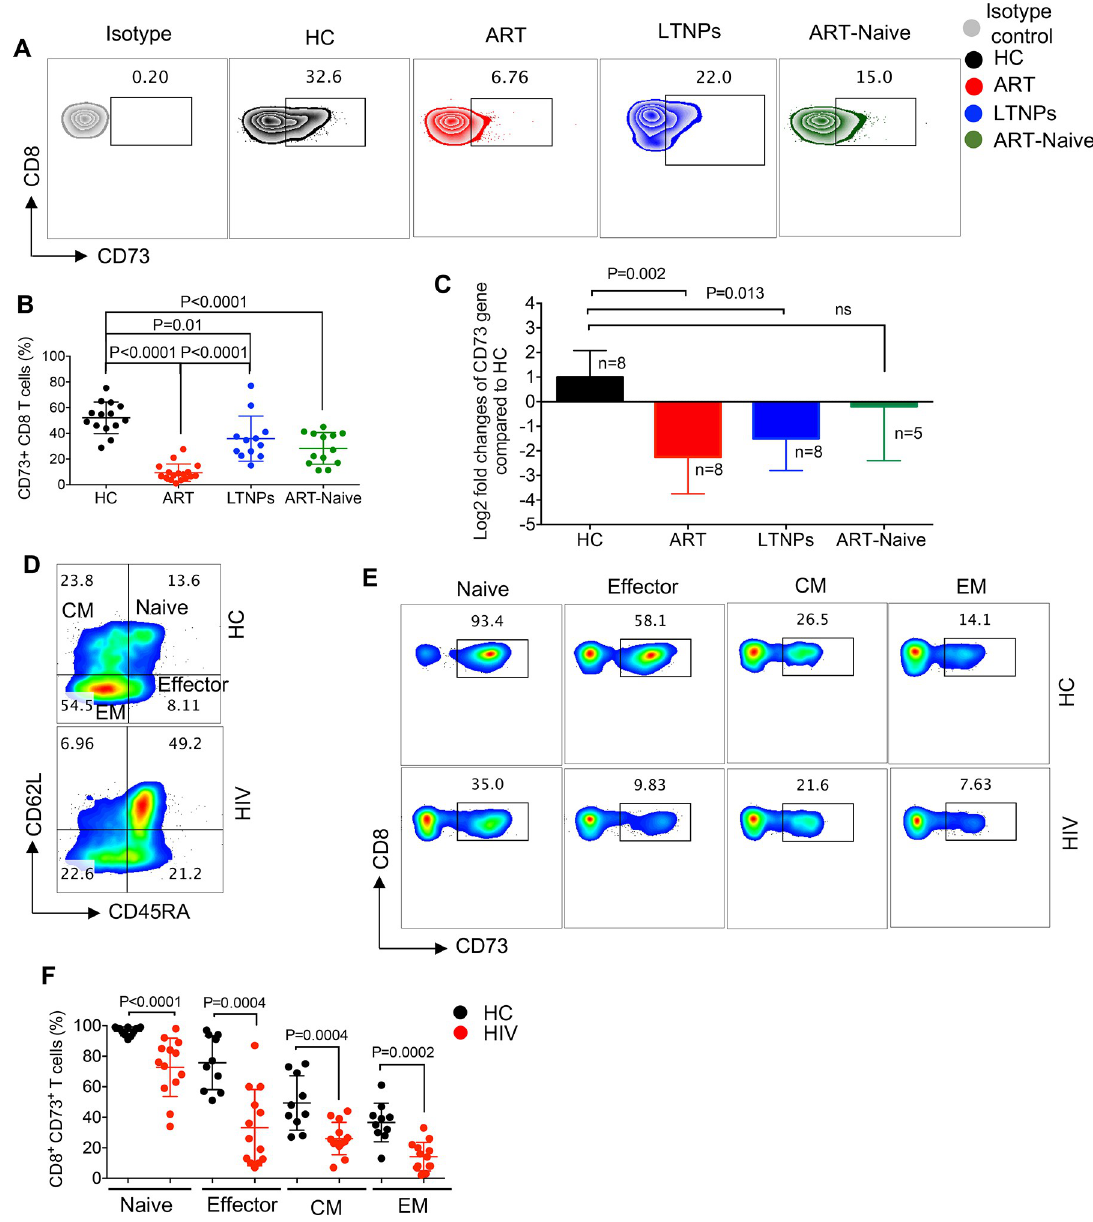
Fig 2. Global reduction in the frequency of CD73 + CD8 + T cells in HIV-infected individuals. ( A ) Representative flow cytometry plots, and ( B ) Cumulative data showing intra-cellular expression level of CD73 in CD8 + T cells in HCs compared to HIV-infected individuals either on ART, ART-naive or LTNP. ( C ) Fold regulation of CD73 gene in CD8 + T cells of HIV-infected individuals (on ART, ART-na ï ve and LTNPs) relative to HCs quantified by qPCR. ( D ) Representative flow cytometry plot showing different subpopulations of CD8 + T cells in a HC versus a HIV-infected individual on ART. ( E ) Representative flow cytometry plots, and ( F ) Cumulative data showing expression of CD73 on different subsets of CD8 + T cells in HCs compared with HIV-infected individuals. Each point represents one human subject either HC or HIV-infected individual. Data are obtained from multiple independent experiments. Each dot represents data from an individual human subject. Statistical analysis determined by the Kruskal–Wallis test (B and C) and the Mann-Whitney U- test (F) with significance indicated. n: reflects the number of samples.